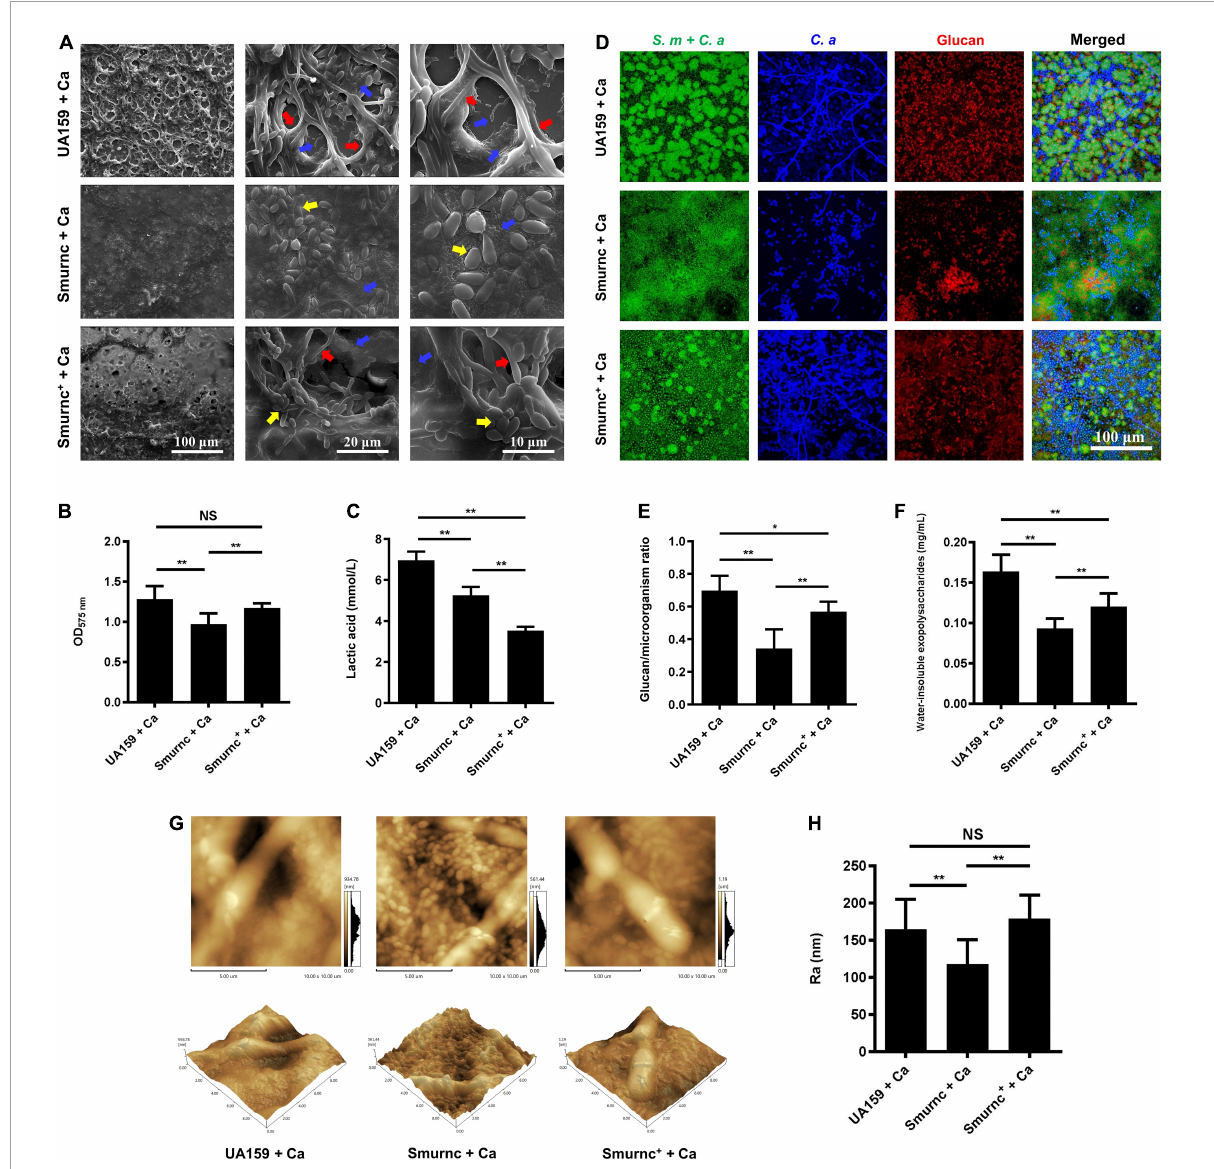
FIGURE2 The regulation of rnc gene in cariogenic characteristics of cross-kingdom biofilm. (A) SEM observation of biofilm architecture. Blue arrows, S. mutans ; red arrows, C. albicans hyphae; yellow arrows, C. albicans yeast cells. Images were taken at 1,000 × (scale bar, 100 µ m), 5,000 × (scale bar, 20 µ m), and 10,000 × (scale bar, 10 µ m) magnifications, respectively. (B) CV microtiter assay was used to quantify the biofilm biomass. (C) Lactic acid generation was assessed by the Lactic Acid Assay Kit. (D,E) Exopolysaccharide production and distribution in biofilms were visualized by CLSM. Green, total microbes; blue, C. albicans ; red, glucan. The glucan to microbes ratio was calculated using Imaris version 7.2.3. (F) Water-insoluble exopolysaccharides from biofilms were measured by the anthrone method. (G,H) Biofilm morphology was detected by AFM, and the surface roughness indicated by Ra (nm) was evaluated. Experiments were performed in biological triplicate. * P < 0.05, ** P <